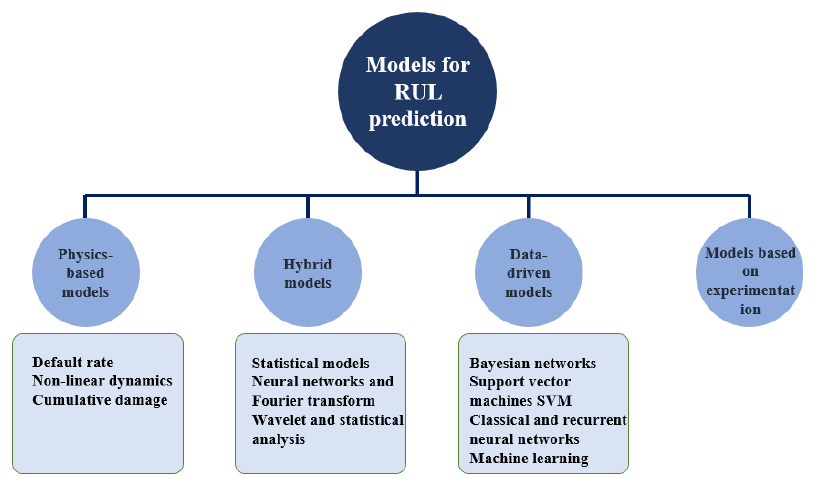
Figure 14. A brief explication of RUL models.